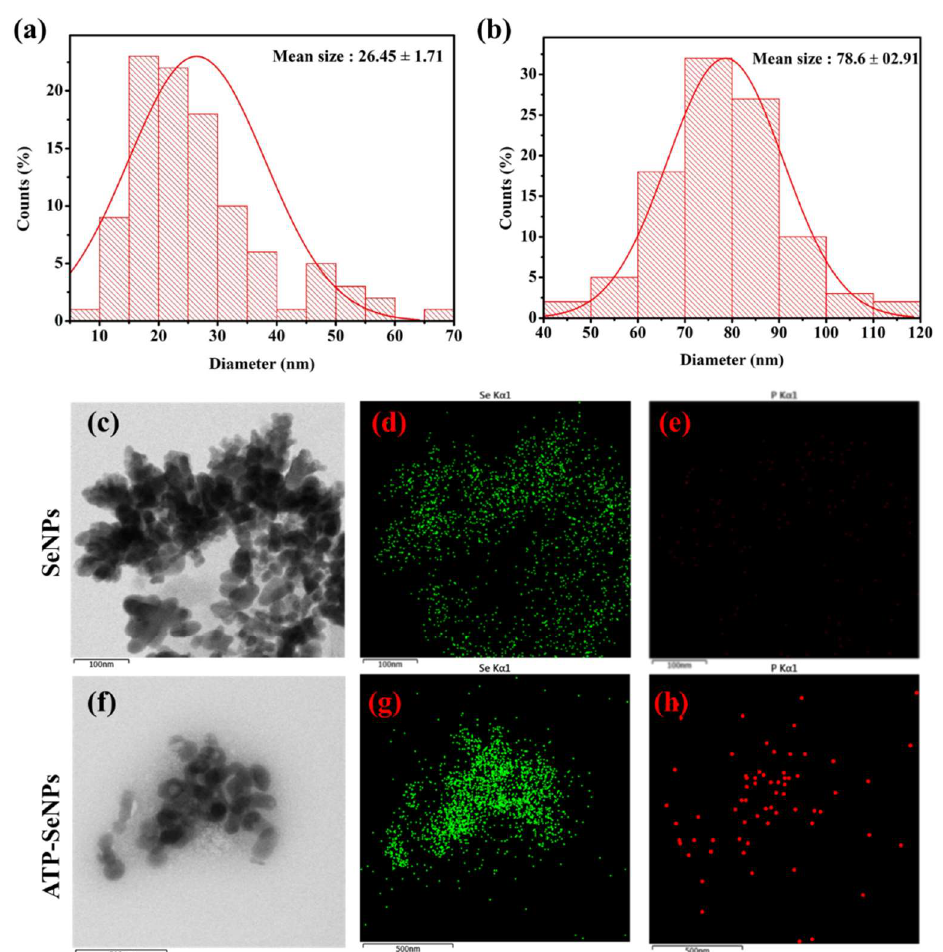
Figure 2. Particle size distribution analysis of SeNPs ( a ) and adenosine triphosphate-conjugated SeNPs (ATP-SeNPs; b ), transmission electron microscopic (TEM) and energy-dispersive X-ray spectroscopy (EDS) analysis of SeNPs ( c – e ) and ATP-SeNPs ( f – h ). The EDS analysis showed mapping of selenium ( d , g ) and phosphate ( e , h ) in SeNPs and ATP-SeNPs, respectively.